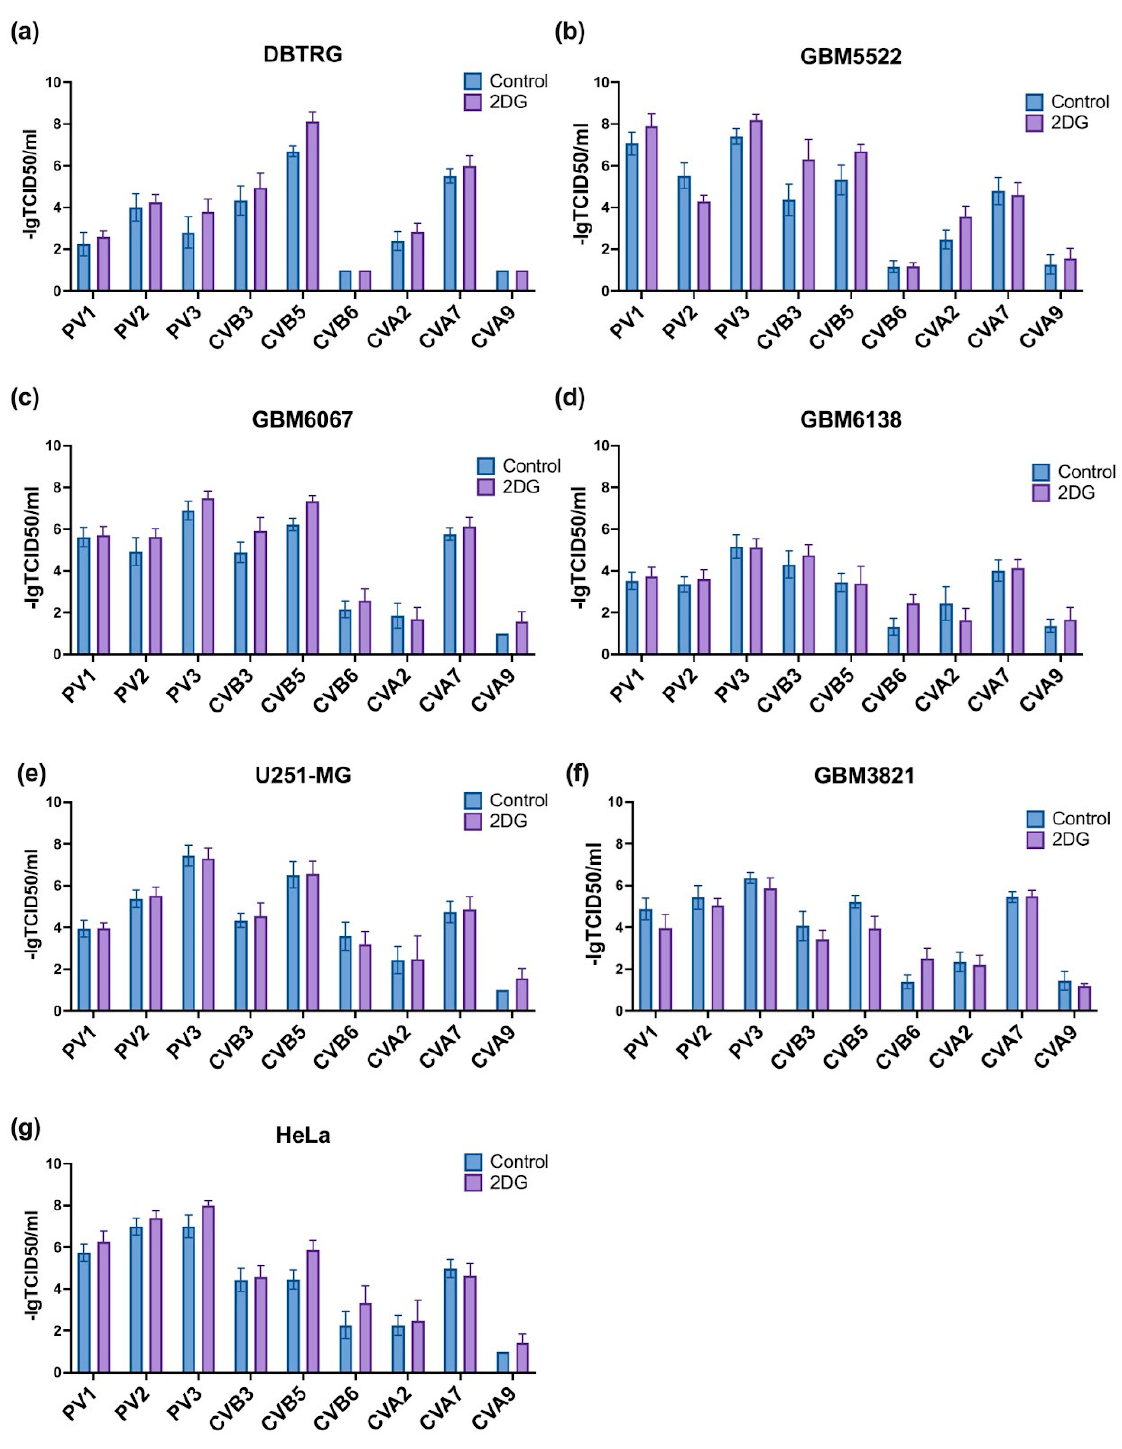
Figure 11. Influence of 2DG on the cytopathic effects of polioviruses and Coxsackieviruses depends on the virus as well as the cell line. DBTRG ( a ), GBM5522 ( b ), GBM6067 ( c ), GBM6138 ( d ), U251-MG ( e ), GBM3821 ( f ) or HeLa ( g ) cells were seeded day before treatment with 4 mM 2DG and simultaneous infection with viruses at MOIs of 0.001–1000. Viability was assessed after 48 h using MTT assay. Values are means ± S.D.